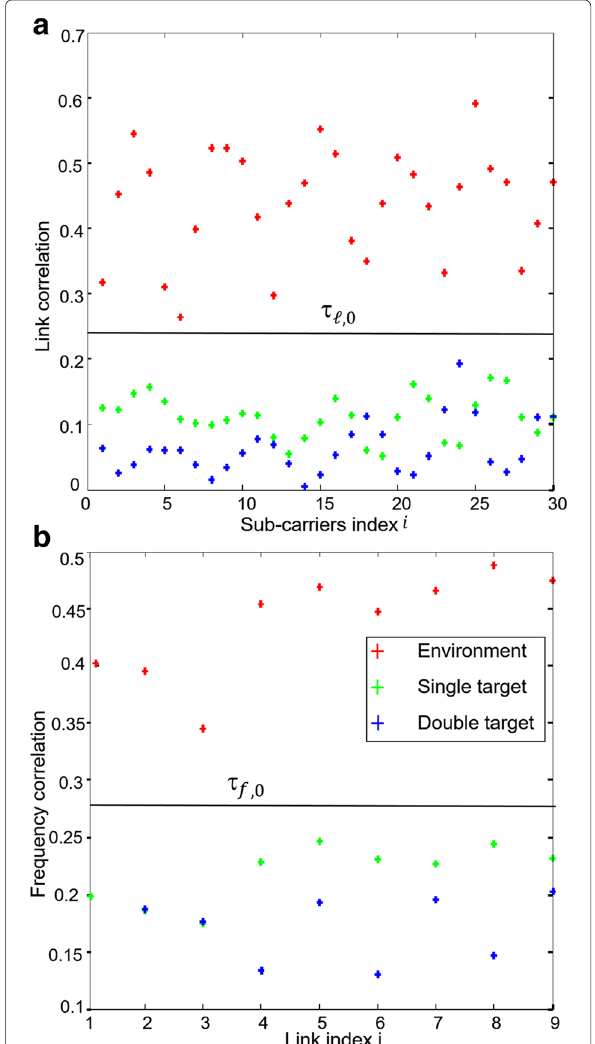
Fig. 7 Examples of a link correlation vs. sub-carriers and b frequency correlation vs. links. Both empty environment (Environment) and occupied environment correlations, corresponding to the single and double target scenarios, are shown. The threshold values τ (cid:2) ,0 = 0.25 and τ f ,0 = 0.28 are